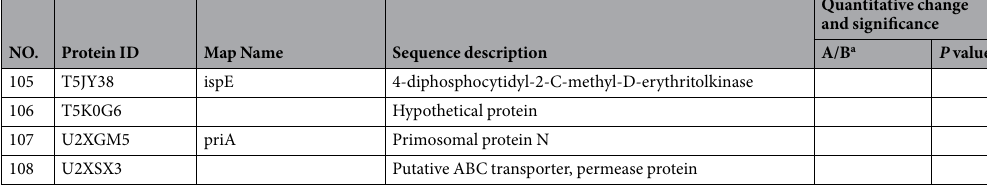
Table 1. Differentially expressed proteins between the luxS mutant and the wild-type strain in mono- cultivation. a A: LuxS mutant strain; B: Wild-type